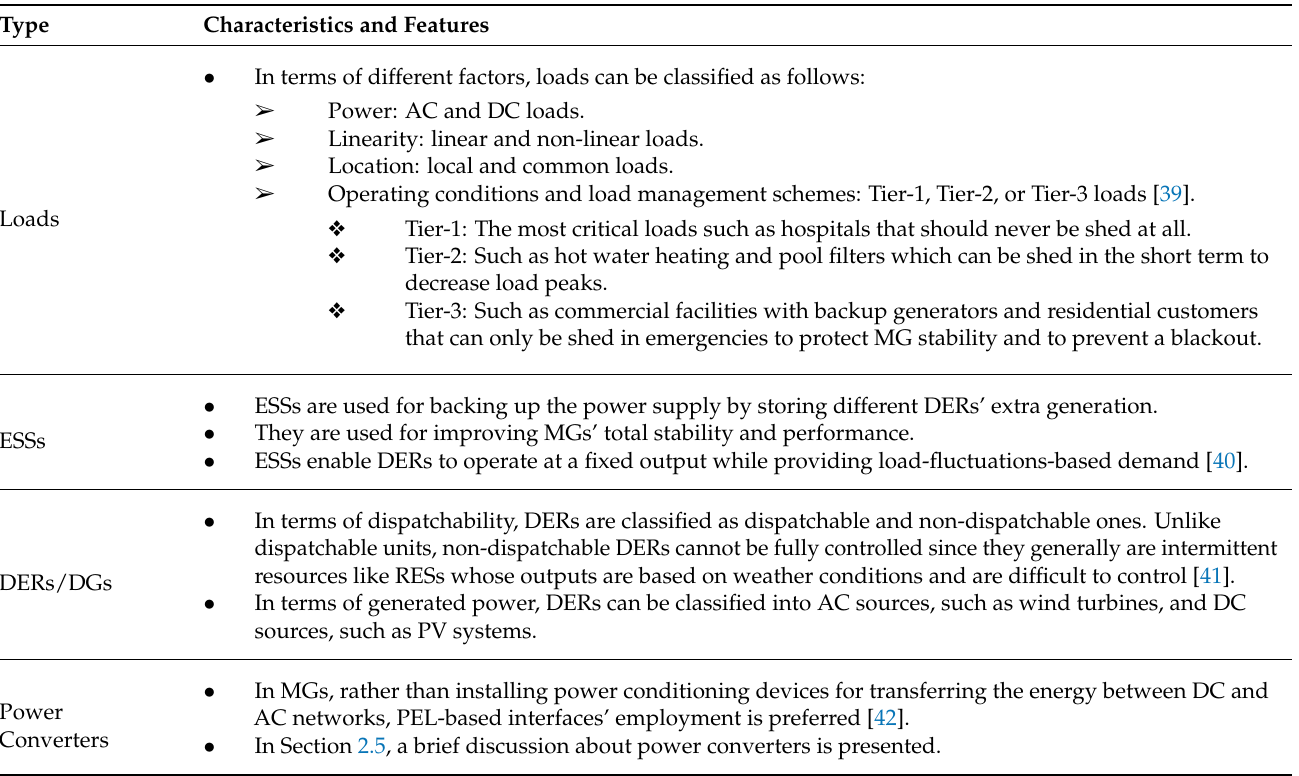
Table 4. Main characteristics of different components of an MG.